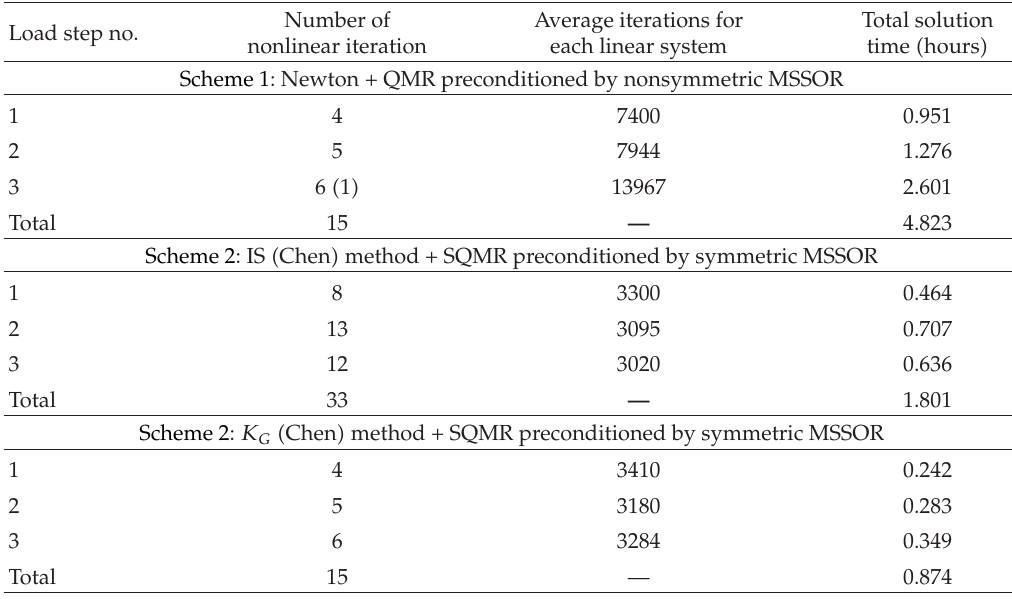
Table 4: Performance of di ff erent solution schemes for the pile-group